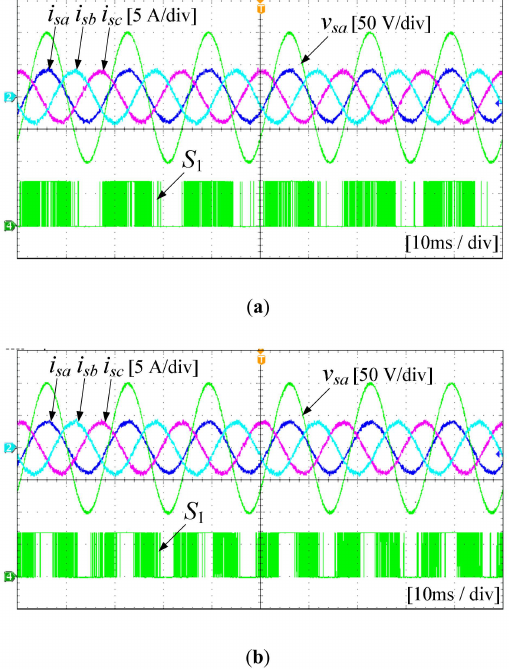
Figure 10. Experimental waveforms of three-phase source currents, a -phase source voltage, and a -phase upper switch obtained from ( a ) the conventional algorithm and ( b ) the proposed